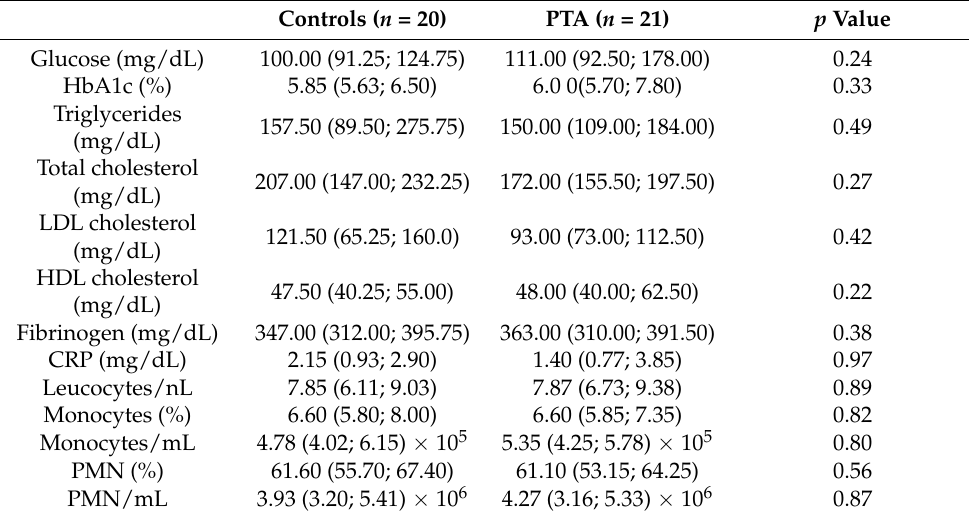
Table 2. Baseline laboratory characteristics and markers of inflammation in the study population.